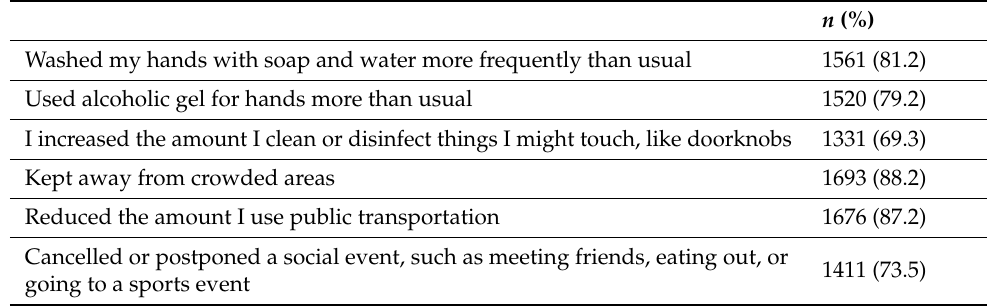
Table 3. Preventing behaviors toward